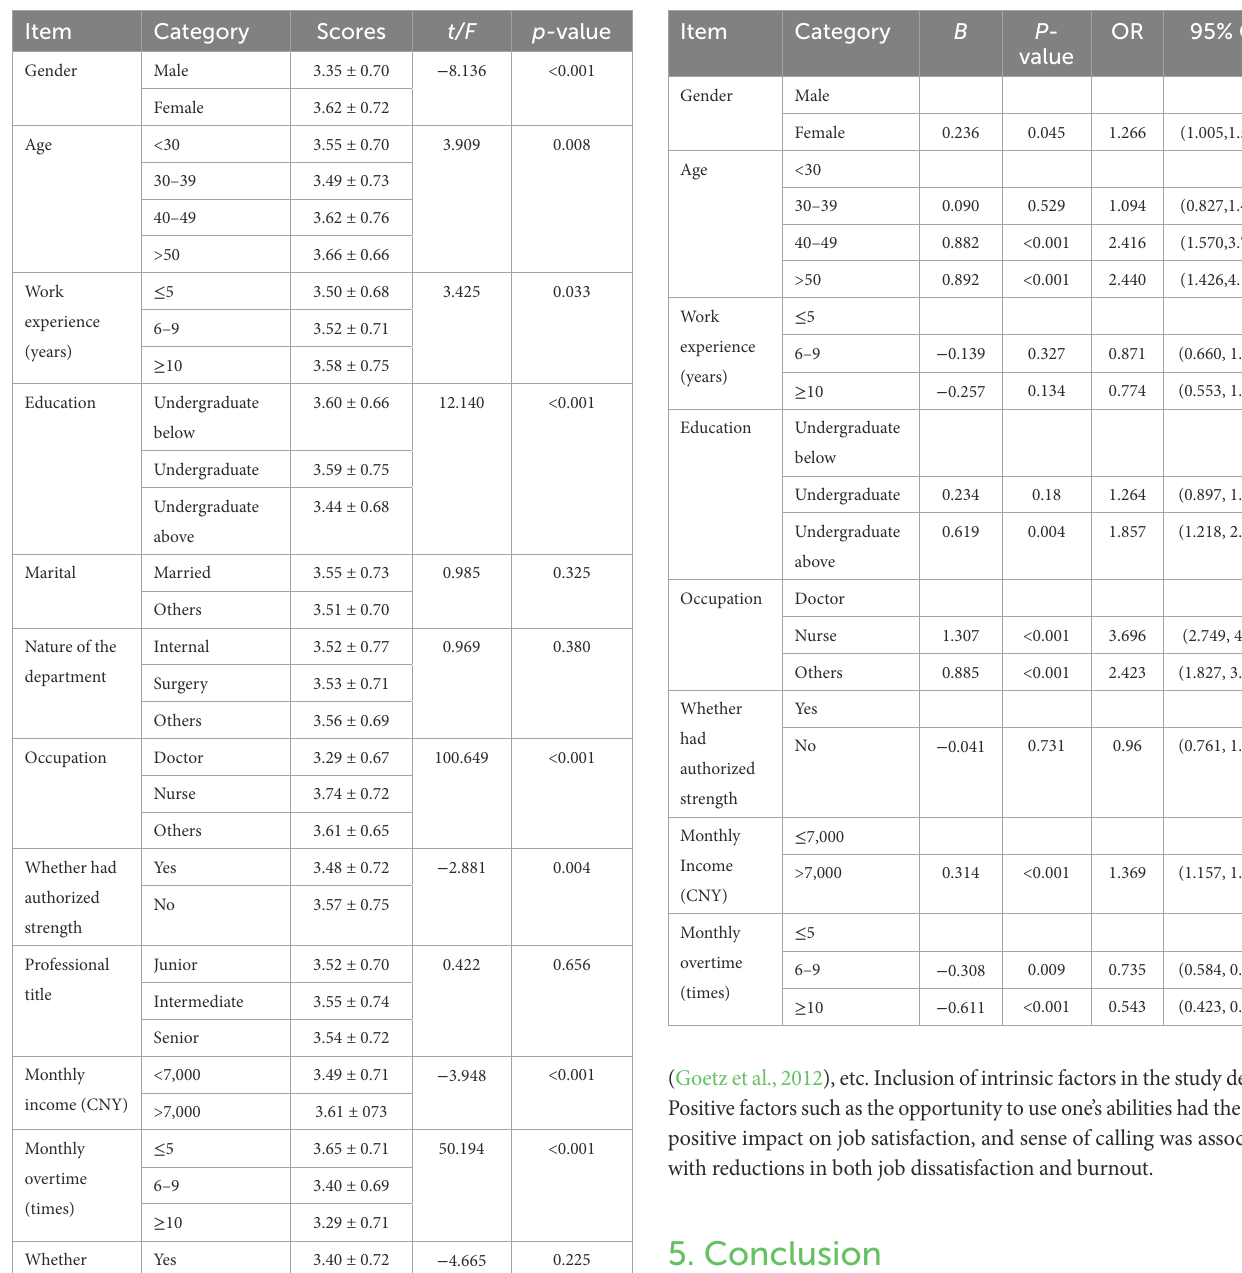
TABLE 3 Single-factor analysis of participants’ job satisfaction ( M ± SD). TABLE 4 Binary logistic regression for job